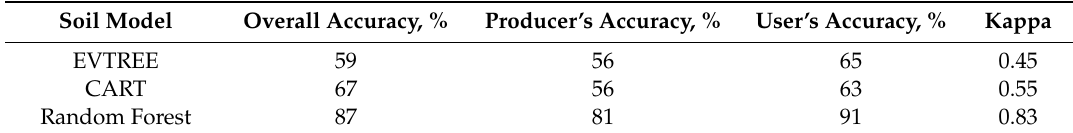
Table 5. Accuracy of the soil maps.